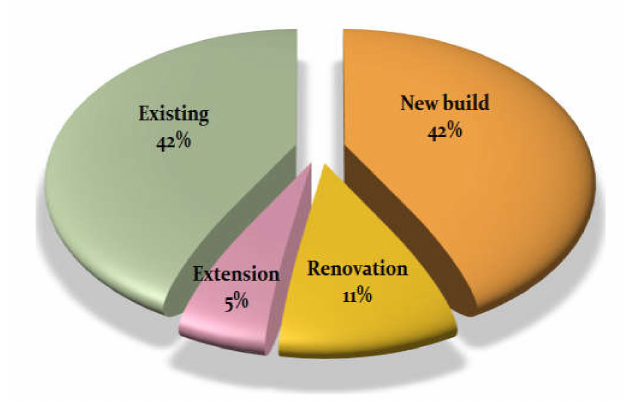
Figure 8. Analysis of project type.